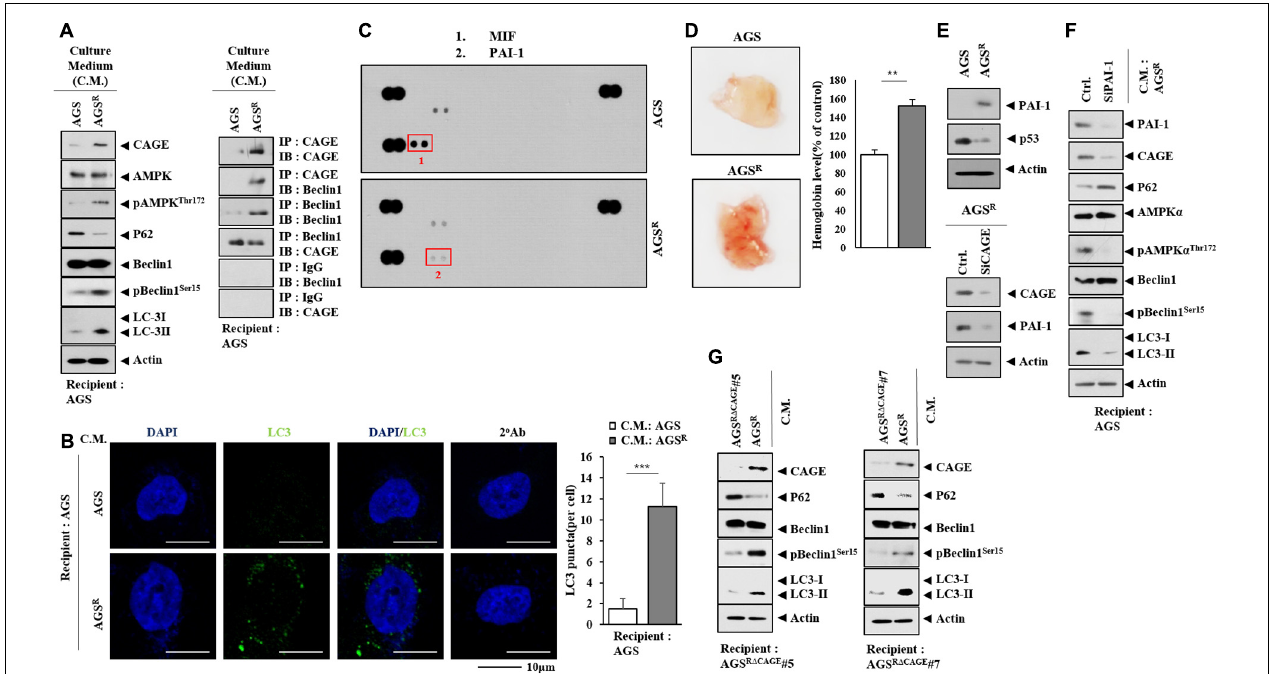
FIGURE 6 | Soluble factors regulate autophagic flux. (A) Culture medium of AGS R cells were added to AGS cells for 24 h. Representative blots of three independent experiments are shown. (B) Same as (A) except that the number of LC3 puncta was determined. ***, p < 0.001. (C) Cytokine array analysis was performed. (D) Matrigel plug assays using culture medium were performed. (E) Immunoblot was performed. Representative blots of three independent experiments are shown. (F) After 48 h of transfection with the indicated siRNA (each at 10 nM), culture medium was added to AGS cells for 24 h. Representative blots of three independent experiments are shown. (G) Culture medium of the indicated cancer cells was added to the CAGE CRISPR–Cas9 cell line for 24 h. Representative blots of three independent experiments are shown.